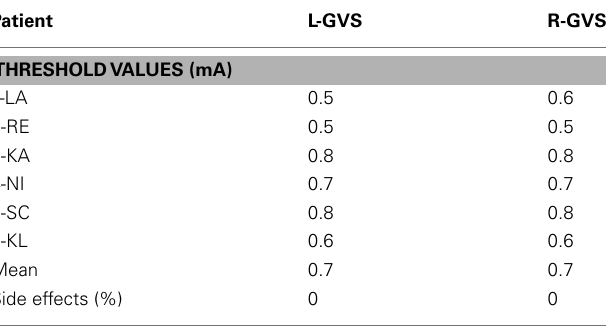
Table 2 | Individual and mean threshold values (milliAmpere, mA) for subliminal GVS conditions for patients in the GVS group and mean number of side effects (%) according to the 34-items-questionnaire, averaged over the GVS group and separately for each GVS condition.